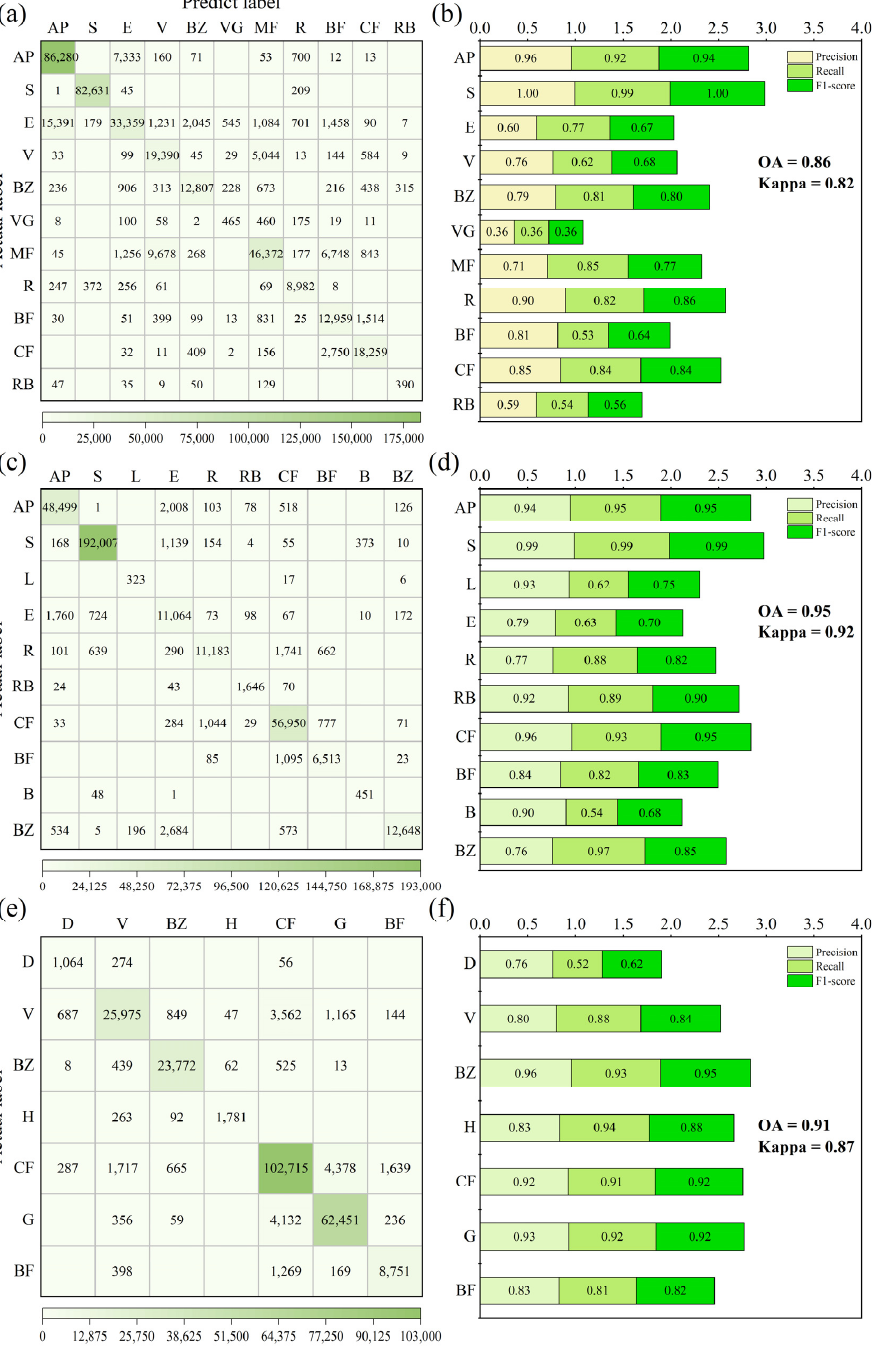
Figure 11. Confusion matrices and evaluation indices calculated over experimental scenes. ( a , c , e ) are the confusion matrices for scenes A, B, and C, respectively. ( b , d , f ) are the calculation results of the evaluation indices for scenes A, B, and C, respectively. The AP, S, E, V, BZ, VG, MF, R, BF, CF, RB, L, B, D, H, and G represent aquaculture pond, sea, embankment, vegetation, building zone, vegetable greenhouse, mixed farmland zone, road, bare farmland, crop farmland, residential building, lawn, boat, ditch, highway, and grassland, respectively.